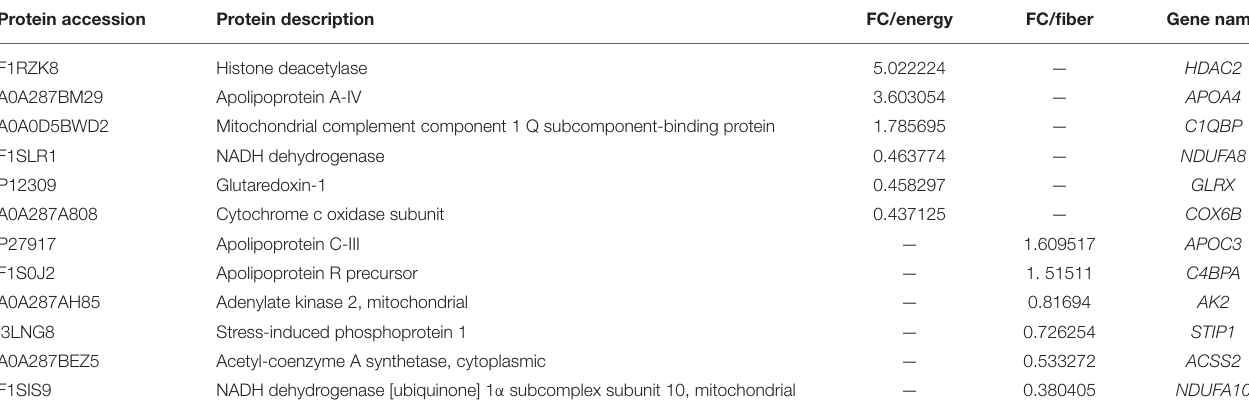
TABLE 3 | Differentially expressed proteins (DEPs) associated with development of mammary glands in the energy and fiber treatments in gilt. Protein accession Protein